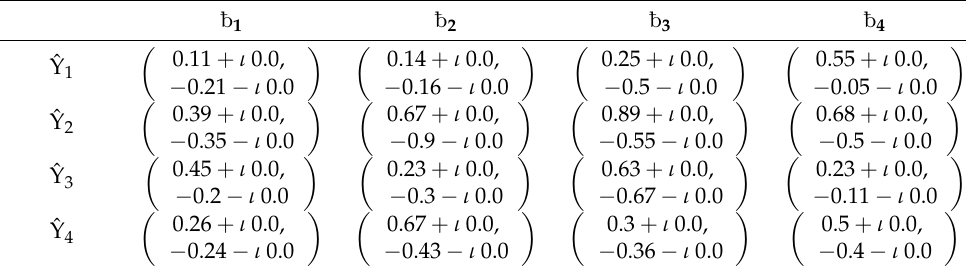
Table 5. Original decision theory contains bipolar fuzzy settings.